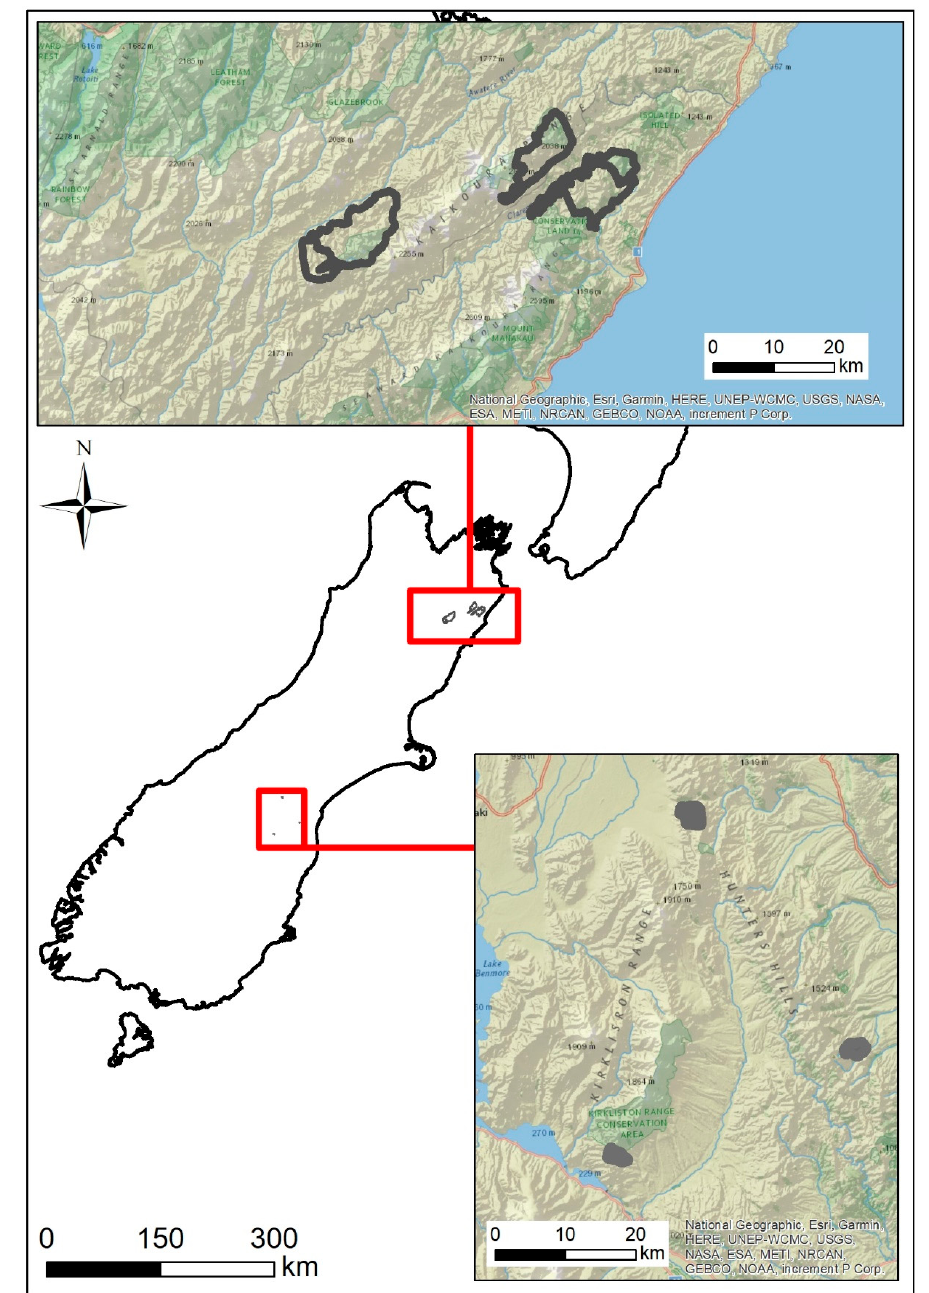
Figure 1. Map of study sites for two wildlife management studies performed on the South Island, New Zealand. Bennett’s wallabies ( Notamacropus rufogriseus ) were captured in the southern site, South Canterbury at three different high-country stations (farms) during 2018–2019. Red deer ( Cervus elaphus ) were captured at the northern site, near the Inland Kaik ō ura Range, south Marlborough in 2019.